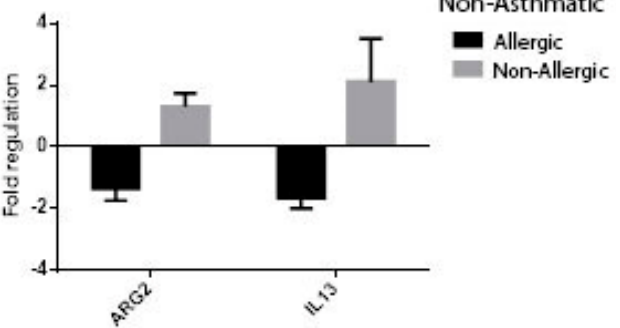
Figure 10. ARG2 and IL-13 expression in patients with CRS and no asthma: allergic vs. non-allergic. p = 0.27.